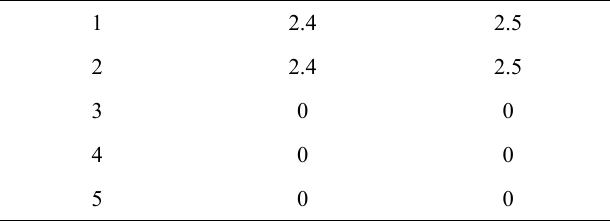
Figure 1. Incremental protocol test. Abbreviations: km = kilometre; min = minutes; h = hour; % =